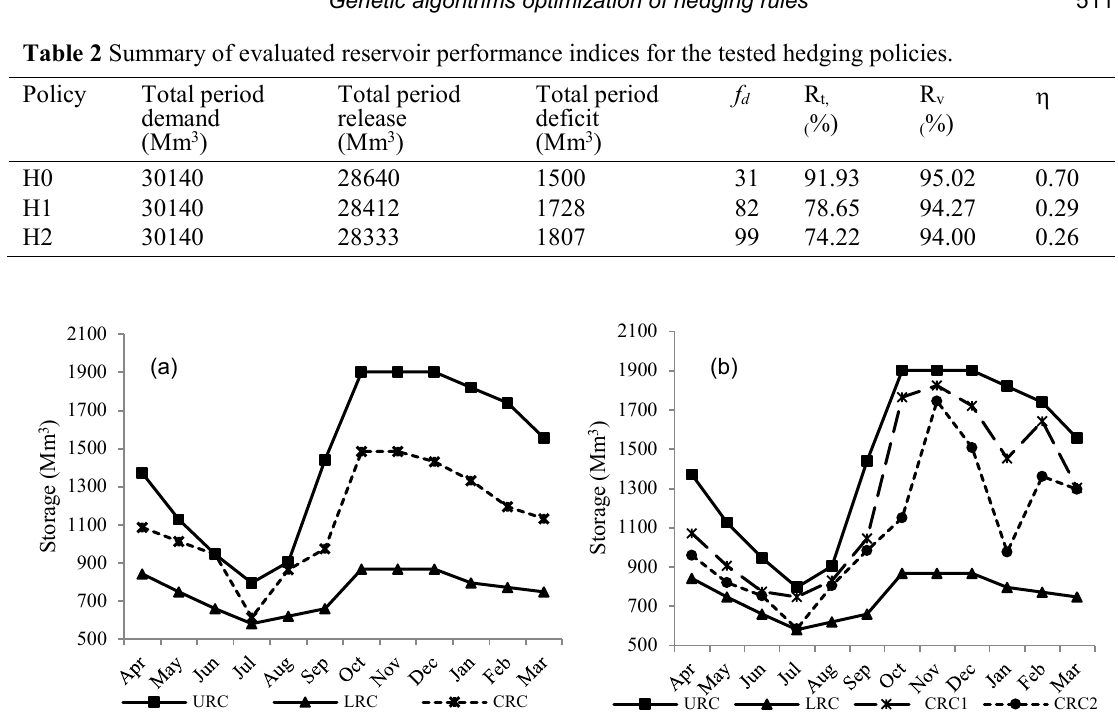
Fig. 2 Optimised hedging rules at Ubonratana for: (a) single-stage (H1) and (b) two-stage